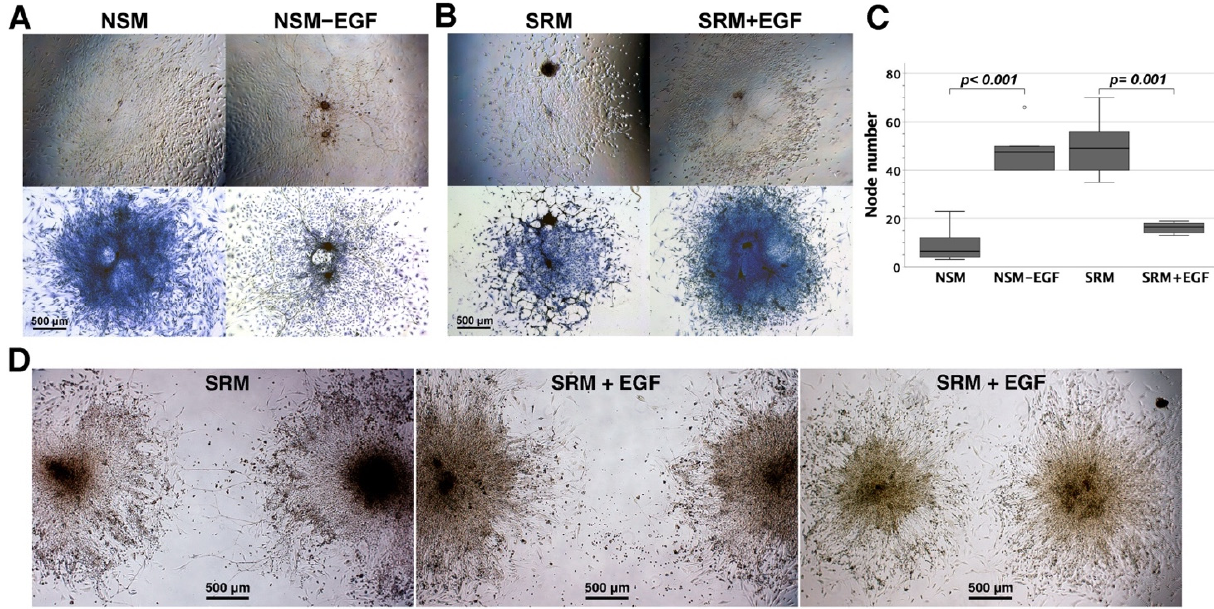
Figure 3. The EGF effects on network assembly of enteric neurospheres. Enteric neurospheres generated in NSM were nurtured adherently in NSM, EGF-free NSM (NSM-EGF), CEE-free SRM (SRM), and EGF-supplemented CEE-free SRM (SRM + EGF) for 1 week. ( A ) NSM-EGF gave rise to neural network assembly in preference to NSM. The networks were photographed live (upper) and after Diff-Quik staining (lower). ( B ) SRM + EGF downregulated neuronal wiring in contrast with extensive neuronal wiring in SRM. ( C ) The neuroconnectivity in the network assembled from a single neurosphere was graded by the amount of neurite intersections after Diff-Quik staining ( n = 6 for each group). Groups NSM-EGF and SRM compared favorably in the intersection number with groups NSM and SRM + EGF, respectively. Outliers (circle) were values of 1.5–3 times interquartile ranges